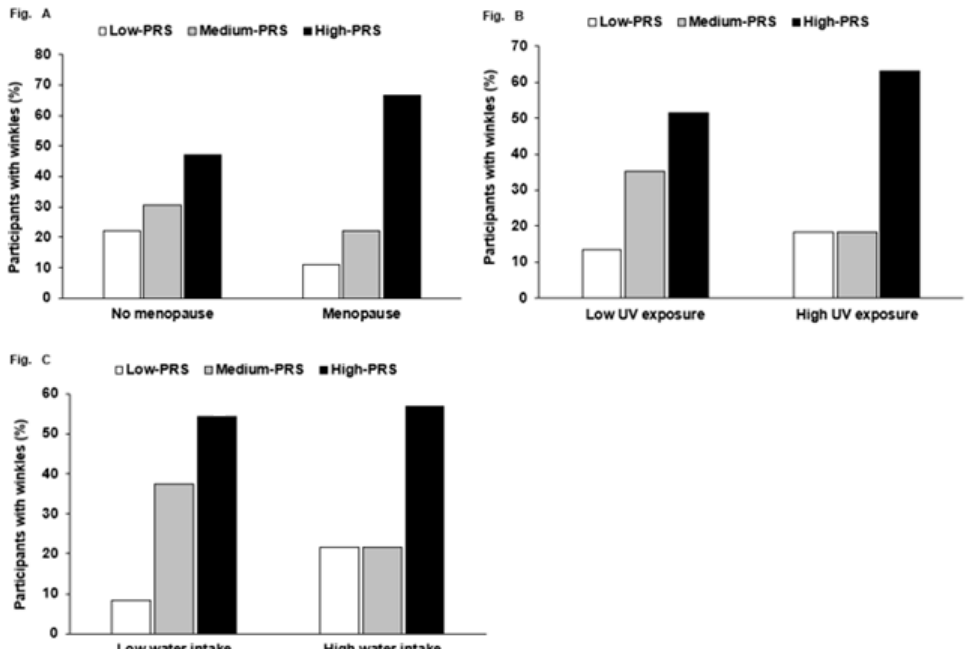
Figure 1. The frequency distribution of participants having wrinkle risk in the three risk groups: polygenetic risk scores (PRSs) according to menopause, UV exposure, and water intake. PRS was calculated by summing the number of risk alleles of three selected SNPs from a genome-wide association study (GWAS) with wrinkle risk, and PRSs were categorized into three groups by the tertiles (low PRS, medium PRS, and high PRS). PRS had an interaction with menopause, UV